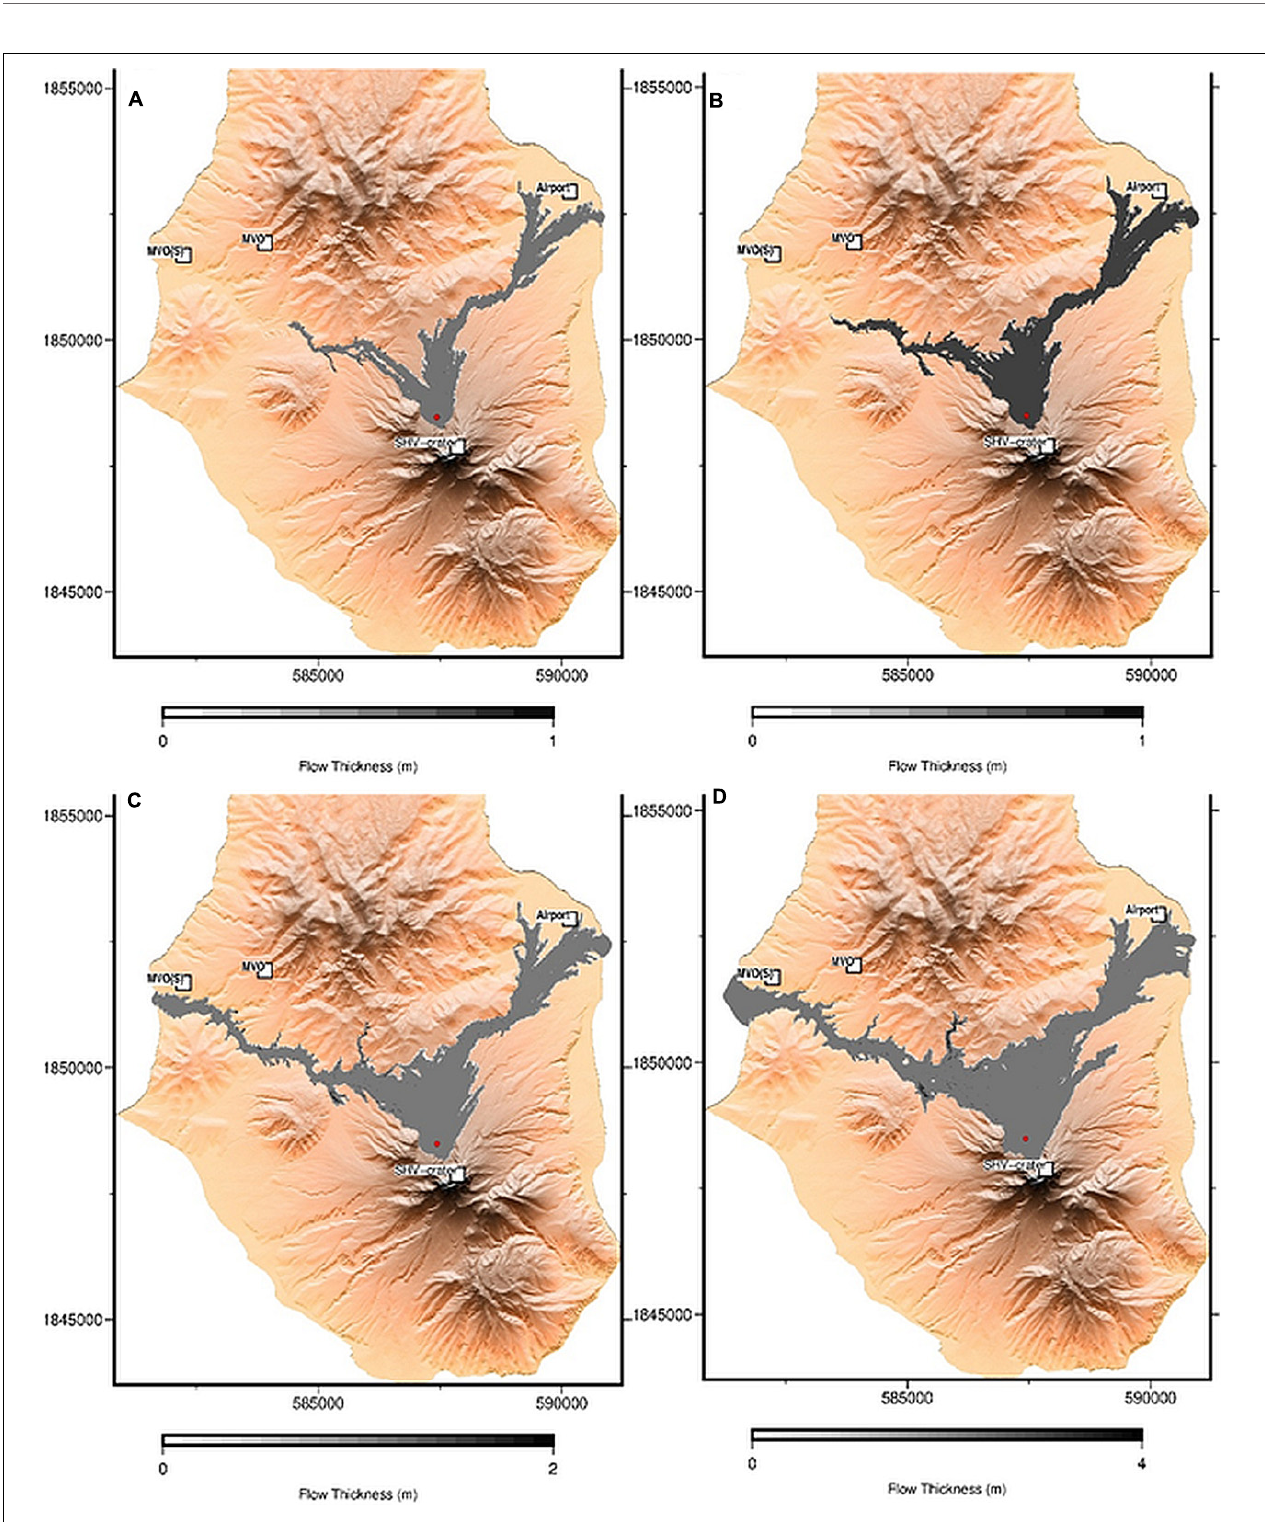
FIGURE 7 | MOLASSES simulations of Soufriere Hills Volcano PDC flow footprints for explosion scenarios: (A) scenario 3: largest 1997 Vulcanian explosion; (B) scenario 5: January 8, 2010 explosion; (C) scenario 6: counterfactual event just reaching MVO[S]; and (D) scenario 7: hypothetical extreme explosion (see Table 1 ). Scenarios 3 and 5 can be compared to actual deposits and runout extents, for instance: Panel (B) footprint emulates the mapped deposits reported by Cole et al. (2014); see Figure 1D ; in panel (C) , a flow volume that just reaches MVO[S] was determined by trial and error. Average flow thicknesses vary in each scenario, from 0 to 1.0 m in (A) ; 0.6 to 1.0 m in (B) ; 1.0 to 2.0 m in (C); and 2.0 to 4.0 m in scenario (D) . The respective flow areas are: (A) 3.7 km 2 ; (B) 5.0 km 2 ; (C) 7.2 km 2 ; (D) 9.7 km 2 .